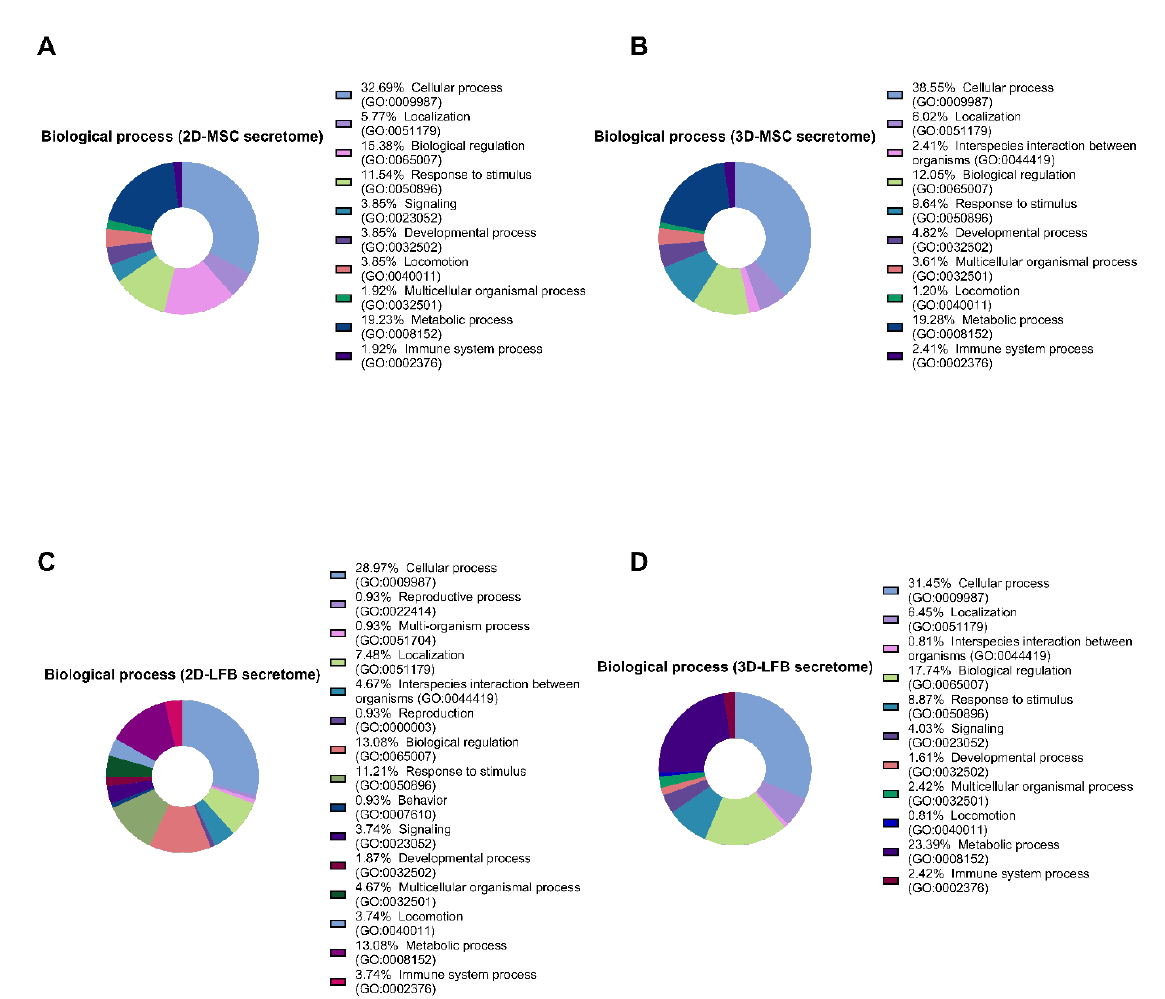
Figure 5. Proteomic analysis of multipotent mesenchymal stromal cell (MMSC) and lung fibroblast (LFB) secretomes. ( A ) Gene Ontology pie chart of biological processes of proteins identified only in the secretome from MMSC 2D cell culture. ( B ) Gene Ontology pie chart of biological process associated of proteins identified only in the secretome from MMSC 3D cell culture. ( C ) Gene Ontology pie chart of biological process associated with proteins identified only in the secretome from LFB 2D cell culture. ( D ) Gene Ontology pie chart of biological processes associated with proteins identified only in the secretome from LFB 3D cell culture. MMSC, multipotent mesenchymal stromal cell; LFB, lung fibroblast.